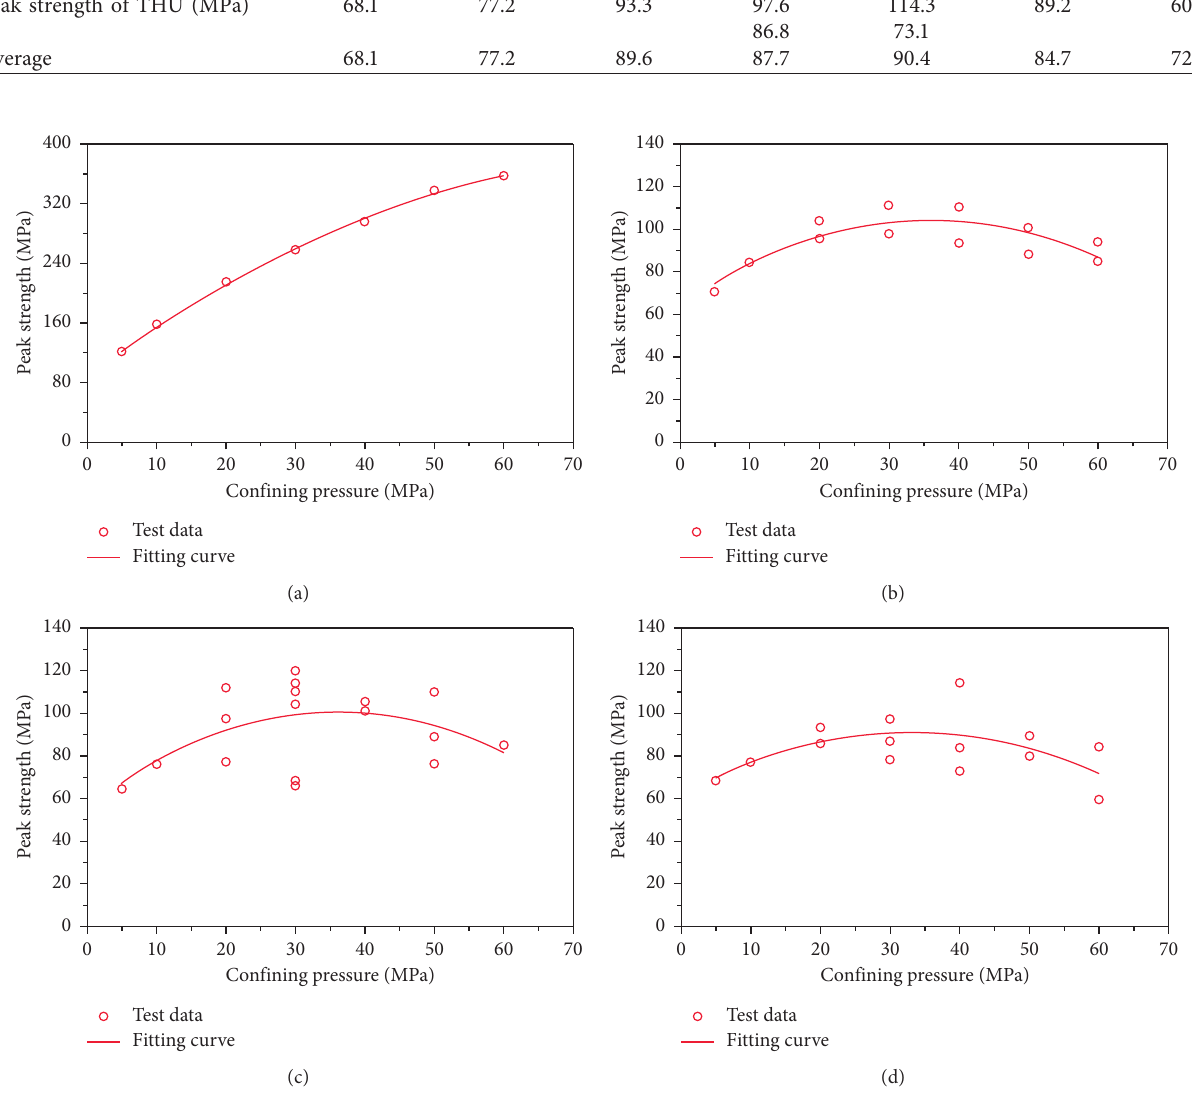
Figure 5: Relationship between the peak strength and confining pressure: (a) TCT, (b) BCT, (c) TLU, and (d)